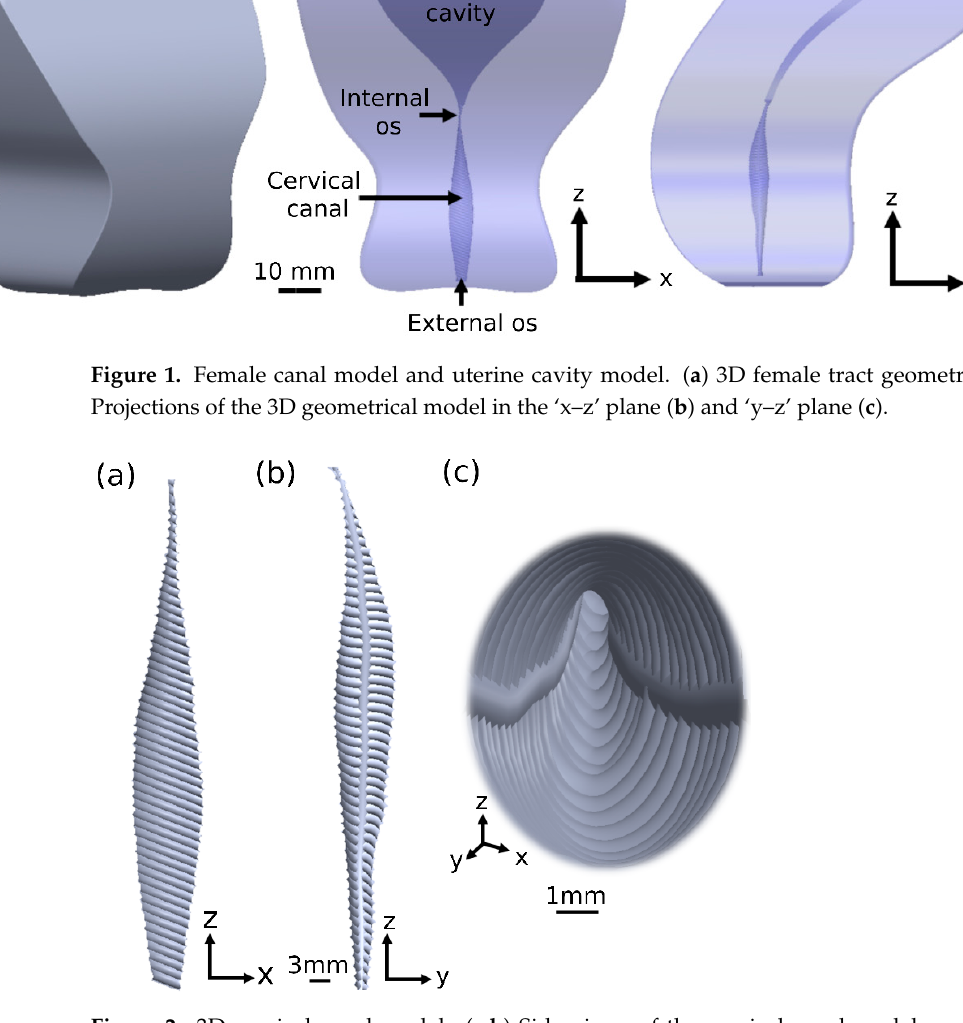
Figure 2. 3D cervical canal model. ( a , b ) Side views of the cervical canal model containing the asymmetrical folds. ( c ) Inside view of the cervical canal model.